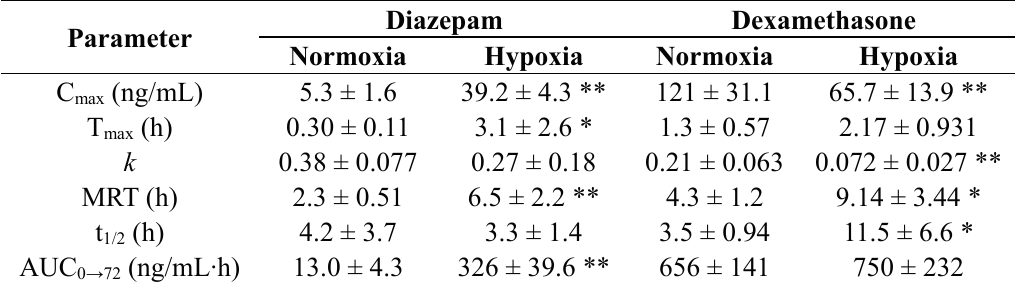
Figure 3. Mean plasma concentration-time curves of diazepam ( A ) and dexamethasone ( B ) in rat with and without hypoxia following intragastric administration to rats ( n = 6). Table 4. Pharmacokinetic parameters of diazepam and dexamethasone to rats with and without hypoxia ( n =